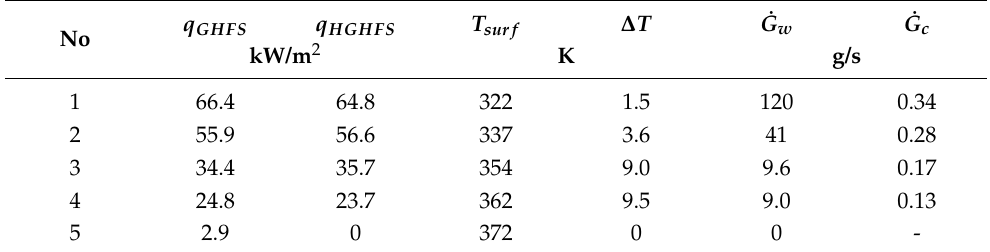
Table 2. The time-averaged results of experiments on selecting the sensor type.